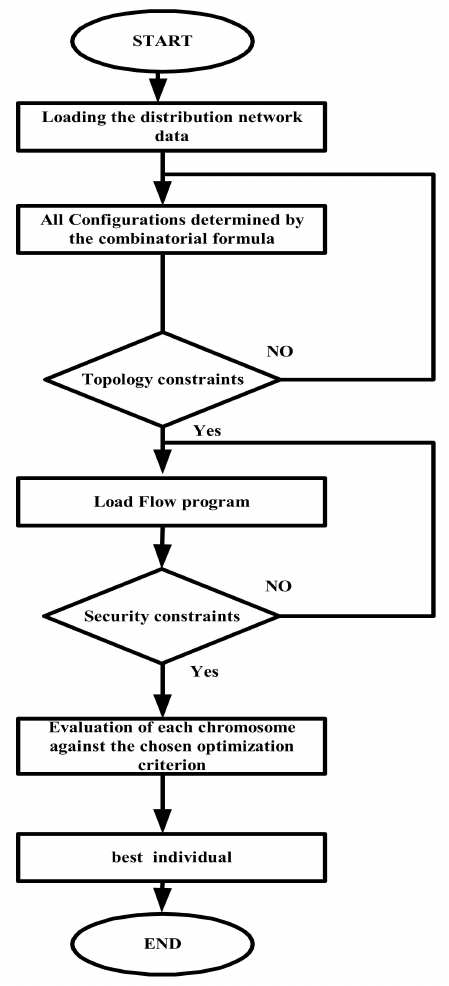
Figure 2. Flowchart of the exhaustive